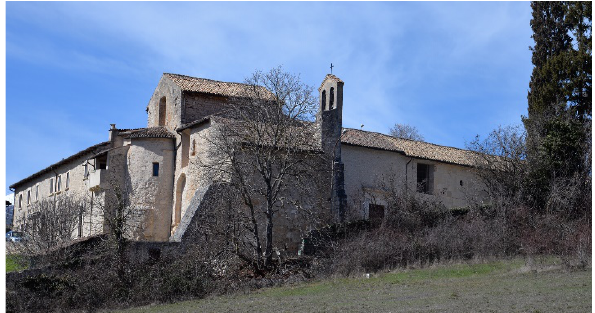
Figure 1. The catacombs of San Vittorino are excavated under the church of San Michele Arcangelo, type with a single nave, where you can access from the transept and the bottom of the